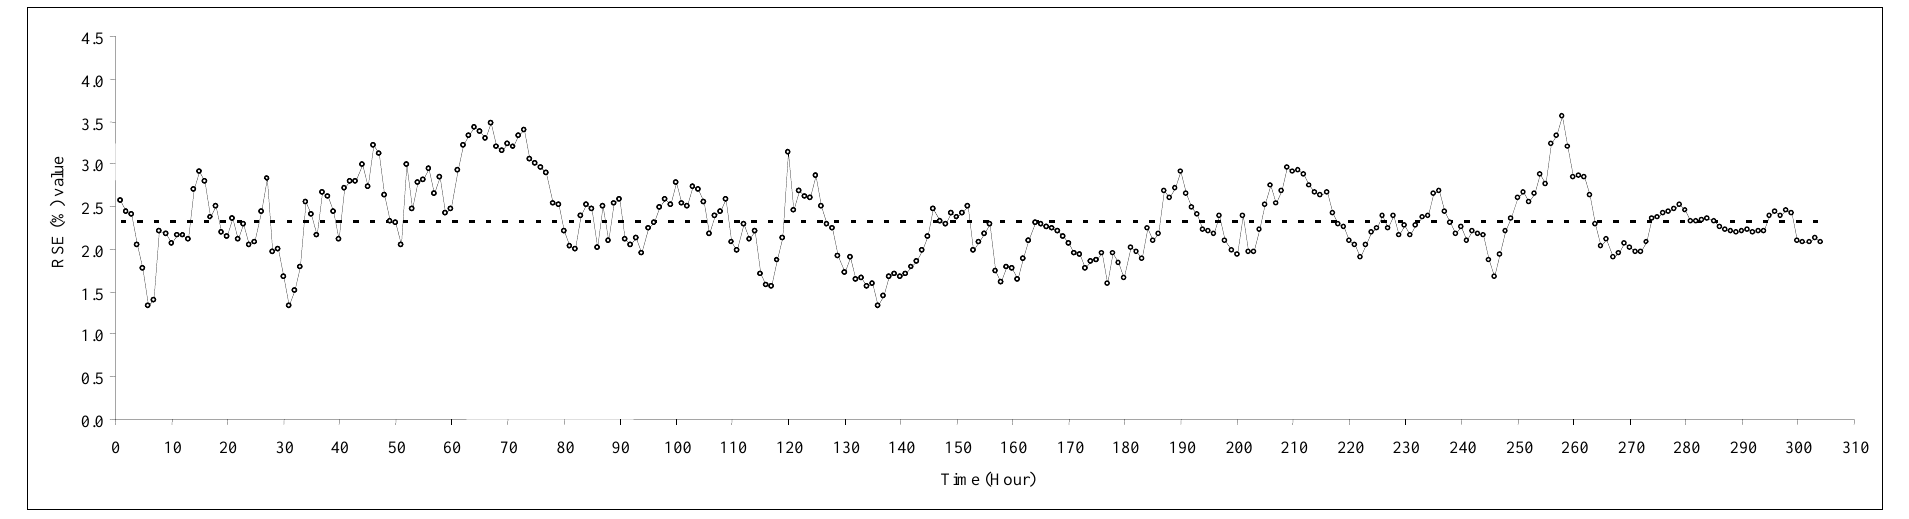
made by 6 sensor units (Dotted line shows the overall mean 2